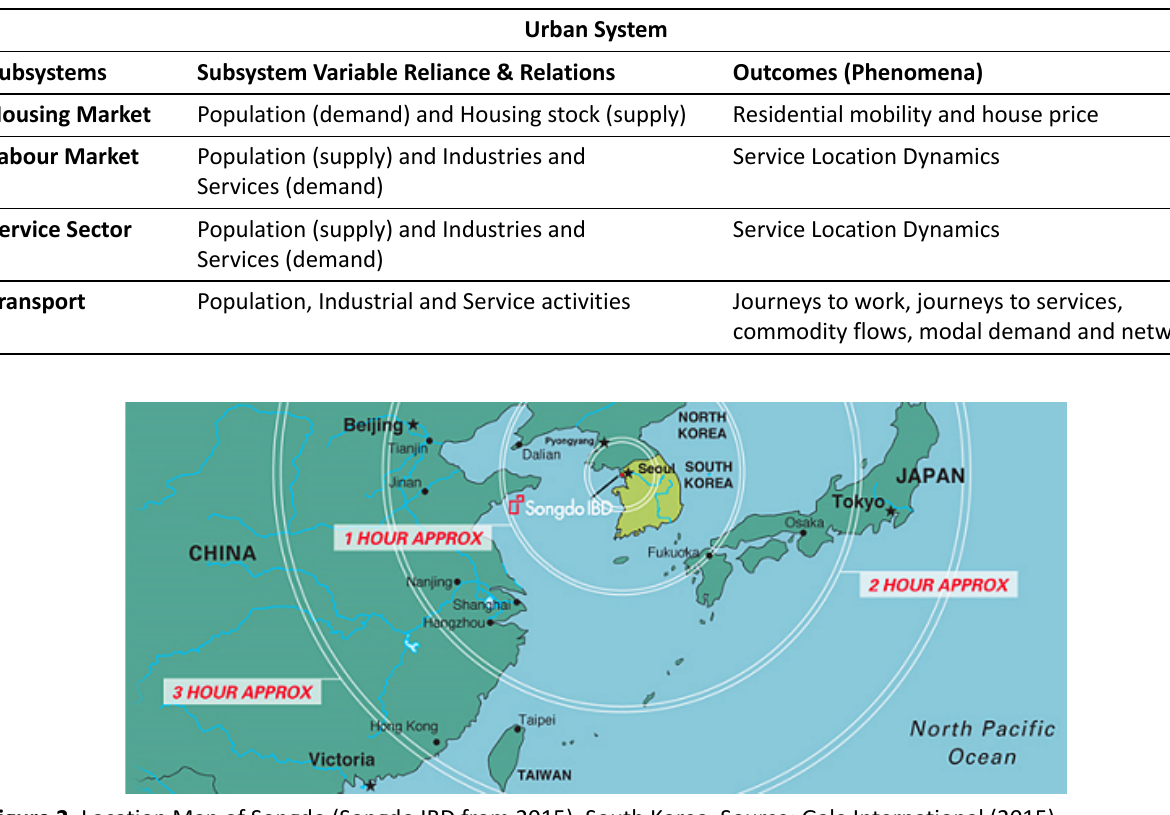
Table 1. Urban systems variables reliance and relations table (Bertuglia et al., 1987, 1994).